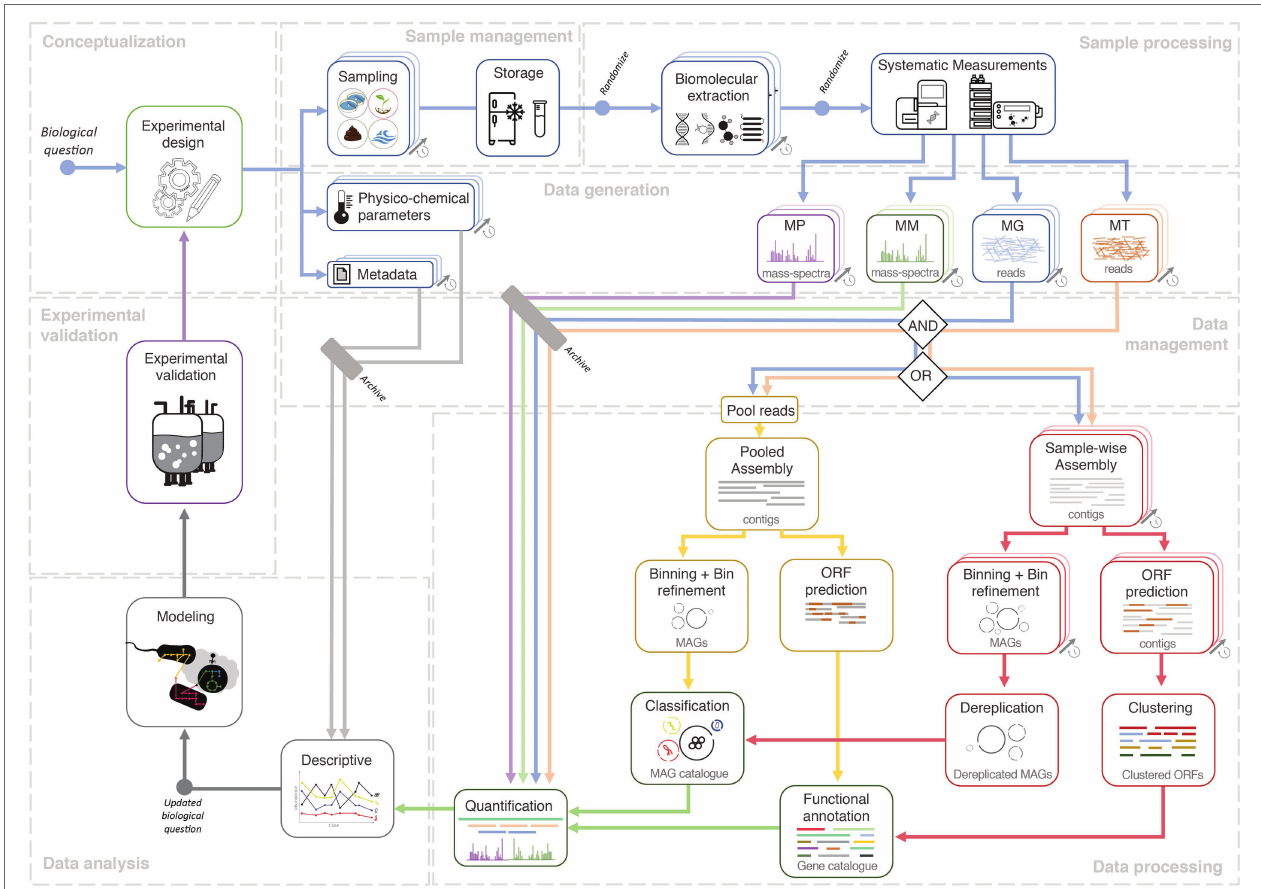
FIGURE 1 | Systems ecology workflow for longitudinal multi-omic microbiome studies. A study conceptualized via an experimental design phase and an initial biological question which is then followed by sample collection, sample management, and systematic high-throughput measurements. The next-generation sequencing (NGS) data could either undergo aggregated processing (yellow track) involving a pooled de novo assembly of NGS reads from all longitudinal samples, to eventually yield a metagenome assembled genome (MAG) and/or gene catalogue via binning and gene calling, respectively. In the dereplication approach (red track), data from each sample are first processed in a sample-wise manner, namely the steps of de novo assembly, binning, and gene calling. The resulting MAGs and predicted ORFs are then merged through a process called dereplication which generates the catalogue. The availability of a catalogue allows